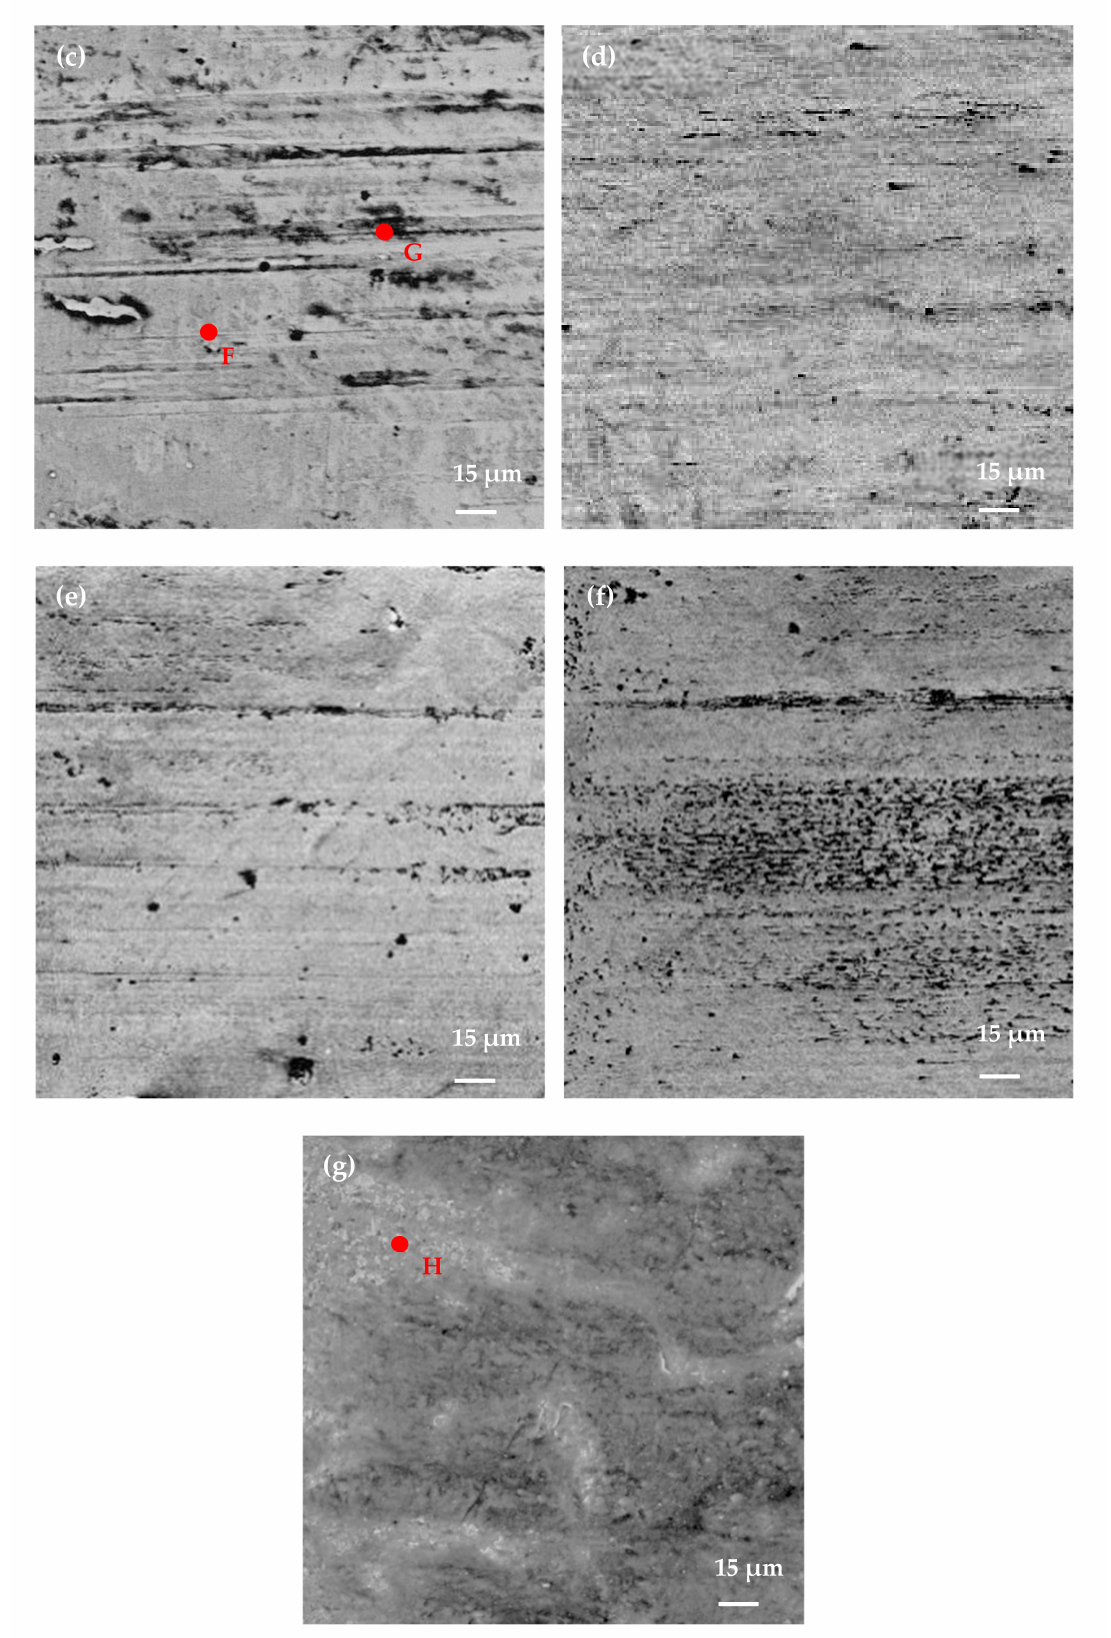
Figure 11. The morphologies of the worn surface of the composite coatings ( a ) T50, ( b ) T120, ( c ) T150, ( d ) T180, ( e ) T200, ( f ) T250, ( g ) T300 (sliding distance 90,000